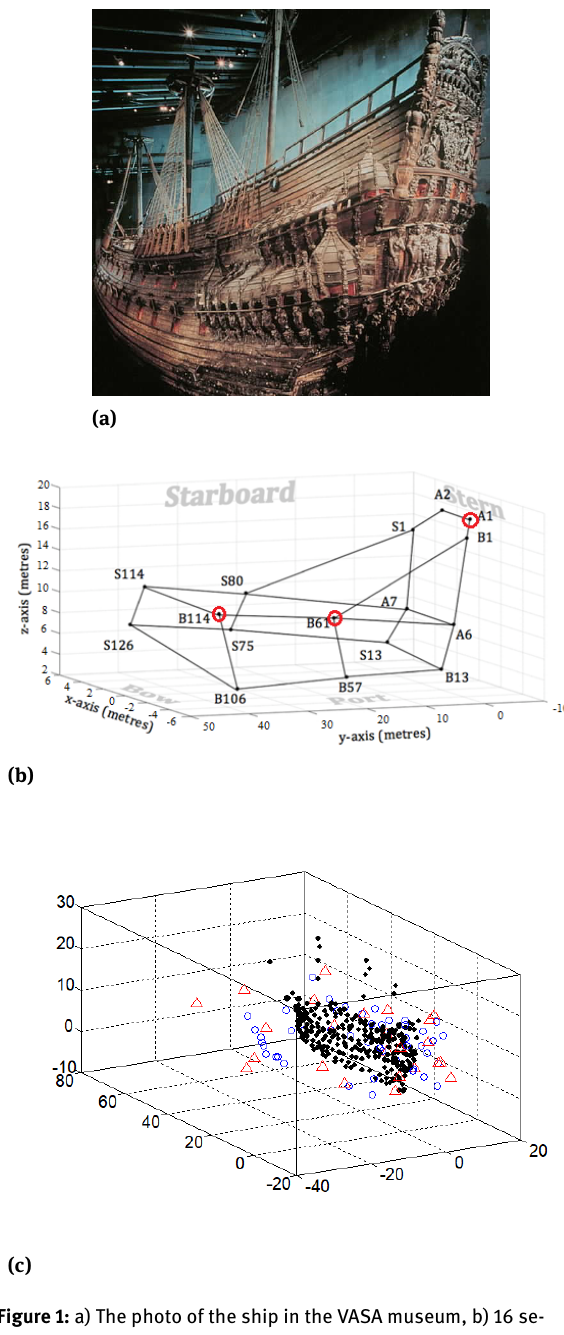
Figure 1: a) The photo of the ship in the VASA museum, b) 16 se- lected points over the ship’s hull, c) Points of geodetic monitoring network. Red triangles – control points, blue circles – station points and black dots – detail points on the